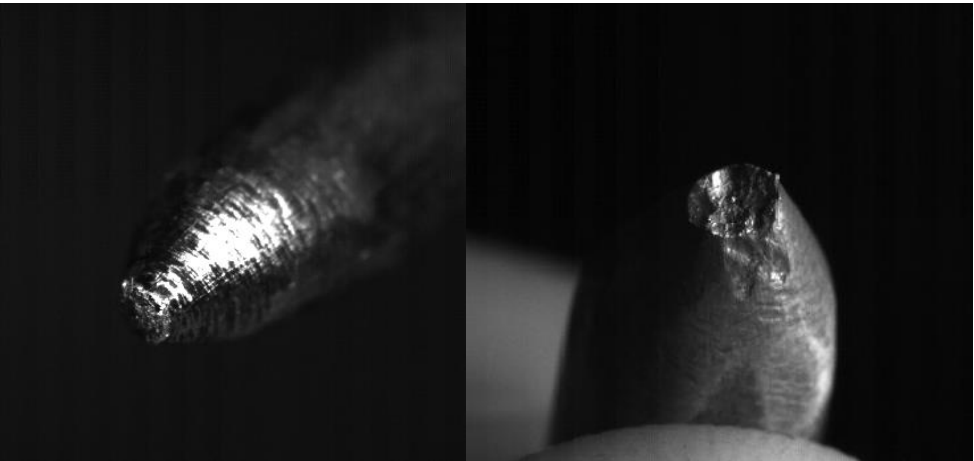
Figure 10. Photographs of the cathode ( left ) and anode ( right ) after the series of 15 experiments for I = 450 A. Diameter of both electrodes is 6 mm.